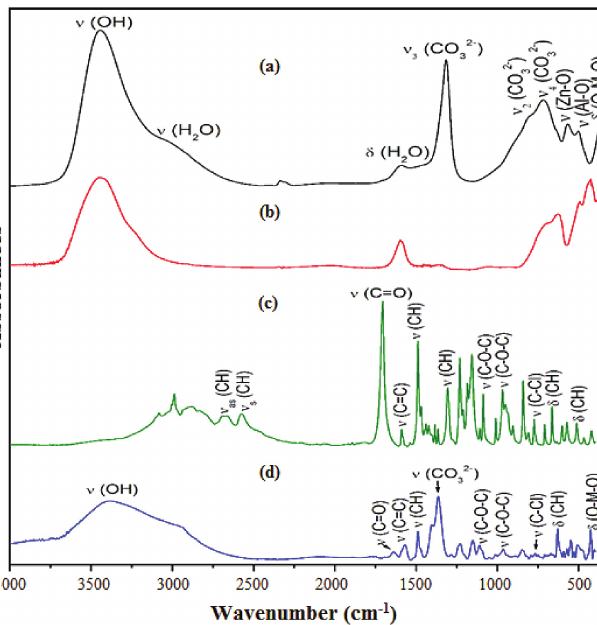
Fig. 8 – IR spectra of LDH (a), CLDH (b), CA (c), and the obtained phase ZnAl-CA after retention of CA (d) (m = 30 mg, [CA] = 500 mg L –1 , pH = 5, tc = 2 CLDH